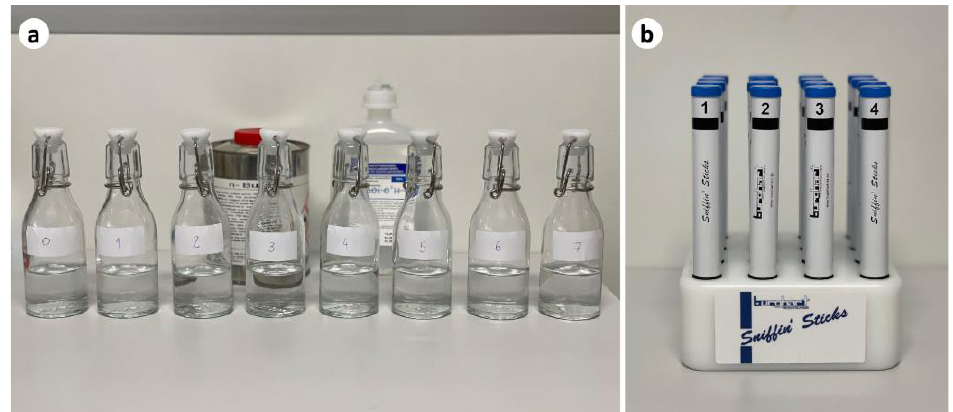
Figure 1. ( a ) The eight bottles used for the Connecticut Chemosensory Clinical Research Center odor threshold test: one blank (0) with deionized water and seven bottles with different dilutions of butanol (numbered 1 to 7); ( b ) the Sniffin’ Sticks ® 16 odor identification test with 16 pens.